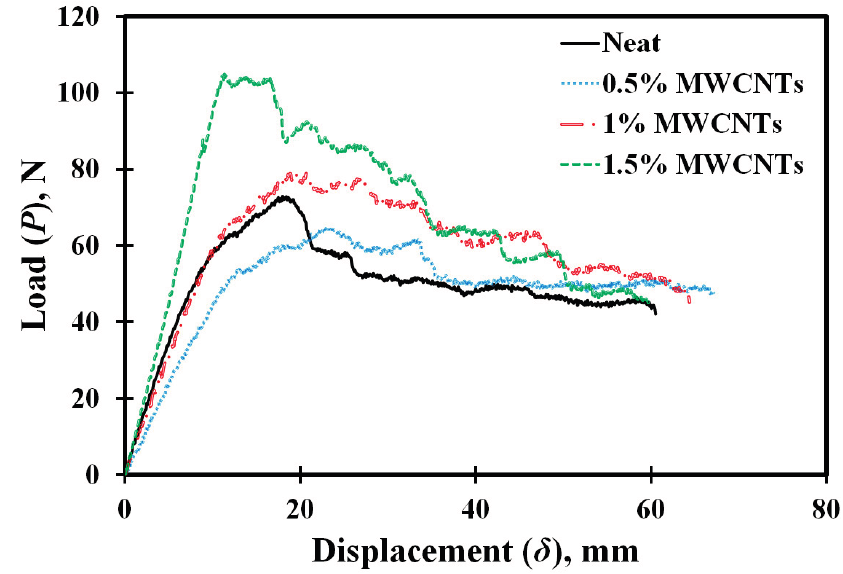
Figure 9. The load-displacement curves for the four representative MWCNTs content